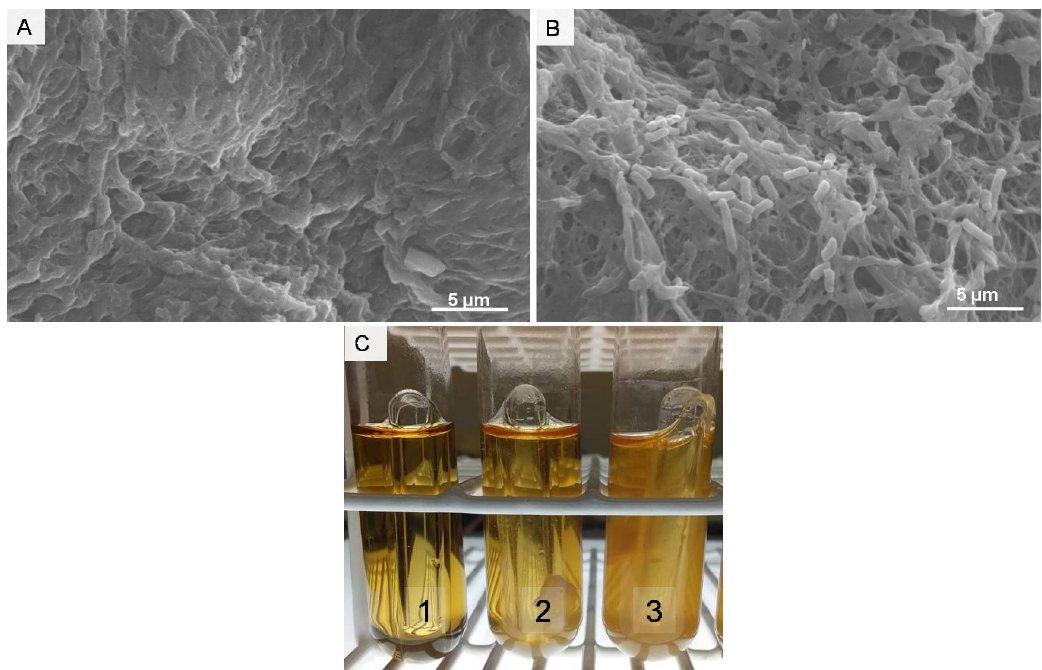
Figure 7. Microbial adhesion in PVA matrices and cell activity in lactose broth. The images shows foam with absence (a) and presence of bacteria E.coli (b) and (c) Durham tube assay: tube 1- blank; tube 2- foam alone; tube 3- foam +